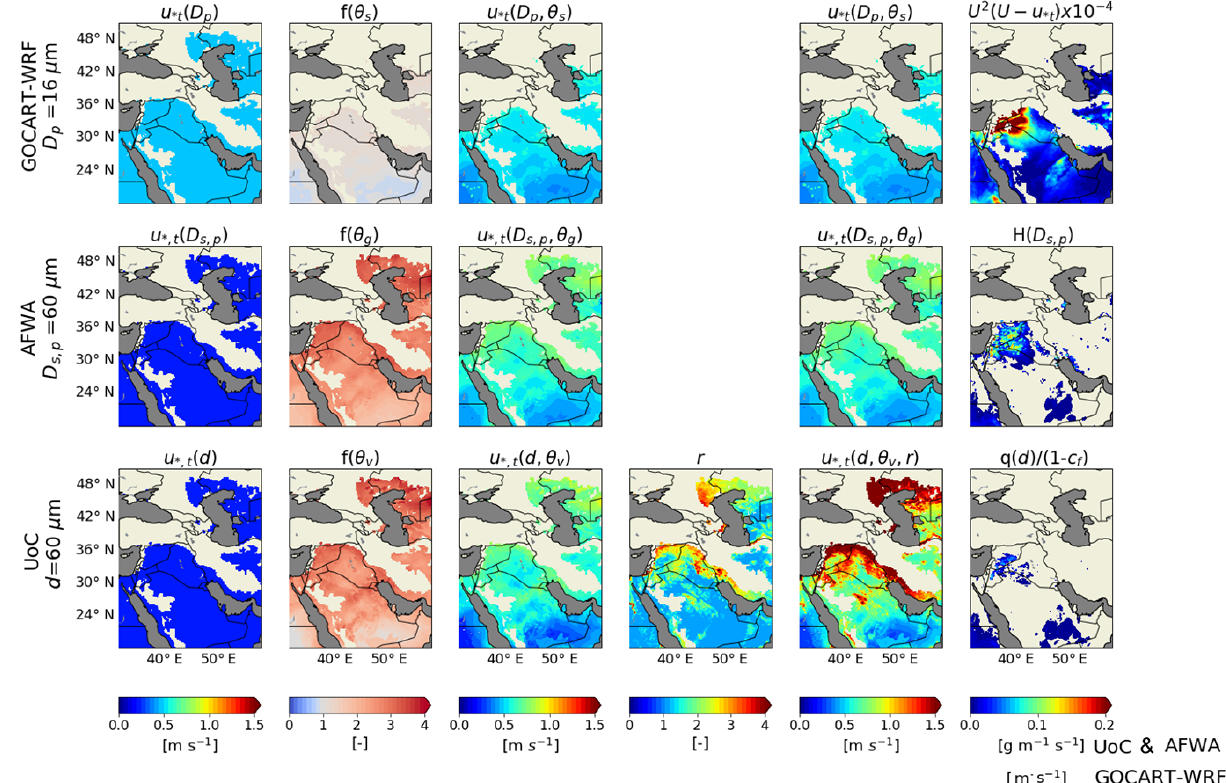
Figure 11. Values of intermediate variables used in the calculation of dust emissions by the three different emission schemes, with the GOCART-WRF scheme in the top row, the AFWA scheme in the middle row, and the UoC scheme in the bottom row. All images reflect model state at 11:00UTC on 25 January 2010. The theoretical dry soil friction velocity threshold for saltation of grains having diameter 60µm (16µm for GOCART-WRF) is shown in column 1, the soil moisture correction factor applied is shown in column 2, and the moisture- corrected threshold is shown in column 3. The surface roughness correction, which only exists in the UoC scheme, is presented in column 4, and the threshold friction velocity after all corrections have been applied is shown in column 5. Column 6 shows the saltation flux of 60µm particles for the AFWA and UoC schemes, as well as a scaled plot of the wind component of the GOCART-WRF emission flux equation for a 16µm particle. Areas of dark gray are water bodies, and areas void of color are areas masked out for vegetation in the source strength